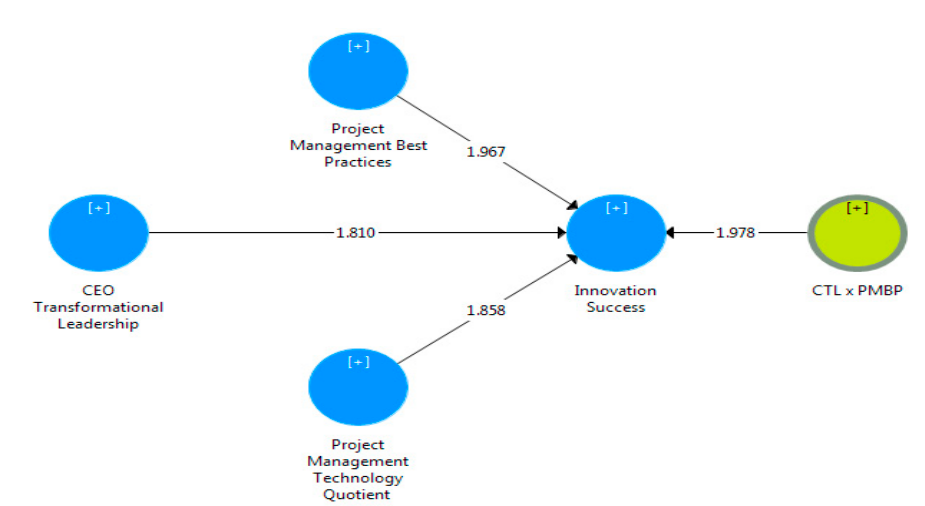
Figure 3. Moderating effects of PMBP.